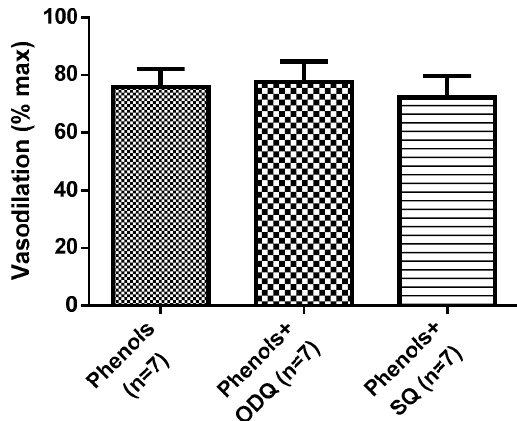
Figure 4. Extra virgin olive oil phenol-induced vasodilation is independent of cyclic nucleotides. Phenols from crude extra virgin olive oil were tested at 3 × 10 − 5 M on isolated resistance mesenteric arteries in the absence (phenols) and presence of the guanilate cyclase inhibitor, 1 H -[1,2,4]Oxadiazolo[4,3-a]quinoxalin-1-one (ODQ, 10 µM) or the adenilate cyclase inhibitor, 9-(Tetrahydro-2 ′ -furyl)adenine (SQ, 10 µM). Data are reported as mean ± SEM, n (experimental number).